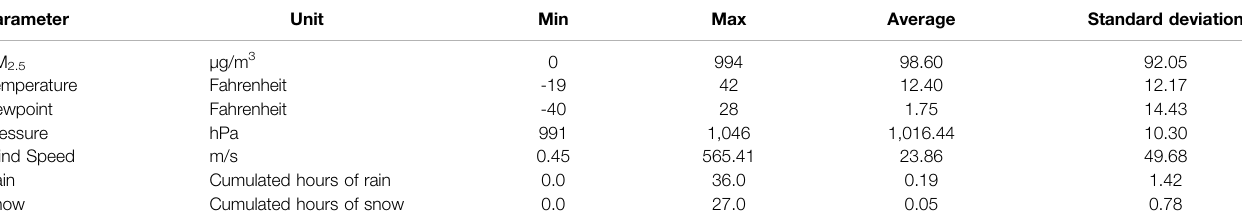
TABLE 1 | Parameter description.